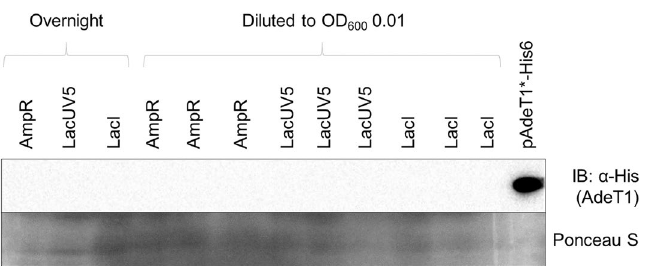
Figure 6. Immunoblotting analysis of AdeT1 production under the control of constitutively active promoters. A single colony was cultured overnight in MHB, then diluted to OD 600 0.01 with three replicates and cultured overnight Full blots are shown in Supplementary Fig.